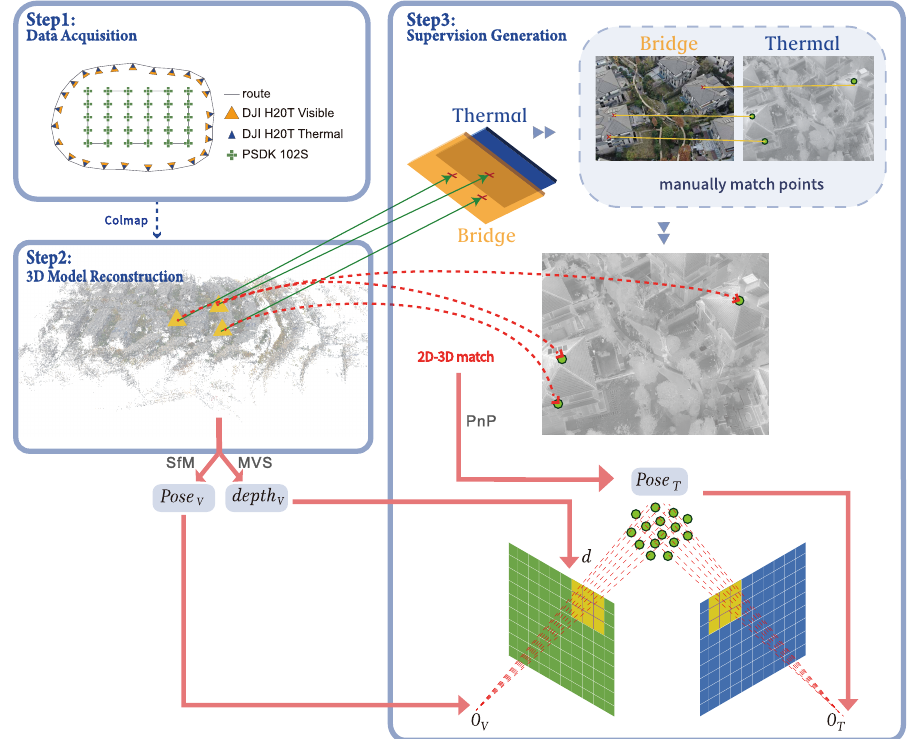
Figure 2. Overview of the dataset construction. The construction of MTV has three components. Step 1 : Data acquisition. We needed to collect different images three times. First, we used an oblique photography camera to take highly overlapping visible light images during the day. The route is shown as the S-track in green. This set of images helps us to reconstruct a high-quality reference 3D model. Then, also during the day, we performed multi-view aerial photography using the visible light lens of the H20T to acquire bridge images. During this time, the flight path and camera perspective were recorded. Finally, we used the H20T thermal lens, following the same flight path and settings as the bridge image, to take thermal images at night, as detailed in Section 3.1. Step 2 : 3D model reconstruction. All of the visible images acquired in Step 1 , including PSDK 102S and DJI H20T Visible, were imported into the offline reconstruction software Colmap [7] for SfM and MVS reconstruction. The output of this step is the absolute pose and depth map of all visible images, denoted by Pose V and depth V , as detailed in Section 3.2. Step3 : Supervision generation. Firstly, according to the visibility, the 3D points of the reference model were projected onto the bridge image to generate marker points. Then, markers that are easy to recognize were picked, while the corresponding points of these markers were manually matched in the thermal image. In this way, we obtained a 2D-3D correspondence between the thermal image and the reference model. The absolute pose of the thermal image ( Pose T ) was obtained using the PnP [38,39] algorithm. Finally, with the Pose V and depth V obtained in the previous step, we could establish the pixel-wise correspondence of the overlapping regions in the thermal–visible image pair through the projection transformation between 2D-3D points, as detailed in Section